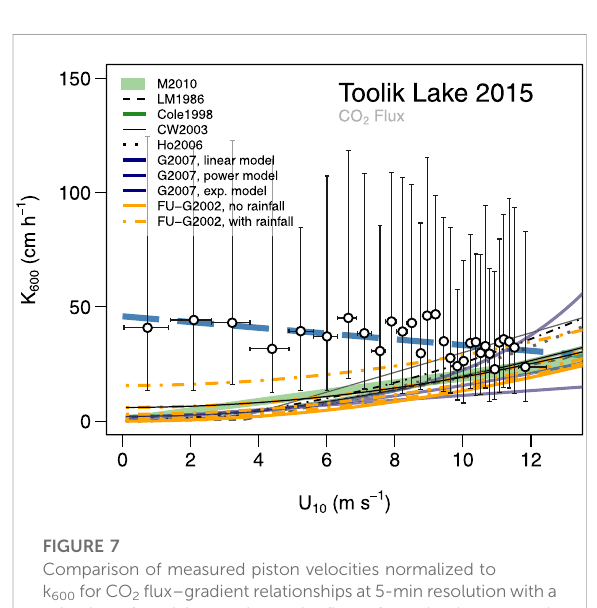
FIGURE 7 Comparison of measured piston velocities normalized to k 600 for CO 2 fl ux – gradient relationships at 5-min resolution with a selection of models to estimate the fl uxes from simpler water – air gradient measurements. Open circles show the median of each bin, approximated by a dashed blue line. Vertical error bars show the inter-quartile range of values (inner 50% of data), whereas the horizontal whiskers show the entire size of the associated bin. Models used are: M2010: MacIntyre et al. (2010), range given by the buoyancy fl ux term; LM 1986: Liss and Merlivat (1986); Cole 1998: Cole and Caraco (1998); CW 2004: Crusius and Wanninkhof (2003); Ho 2006: Ho et al. (2006); G2007: Guérin et al. (2007) with three versions (linear, power, and exponential model); and FU-G2002: Frost and Upstill-Goddard (2002), solid line without precipitation, and dashed lines with 0.05, 0.15, and 0.30 mm h − 1 rainfall. See Table S3 for K 600 model equations used. The U 10 values derived for the 10-m height from local measurements and then enlarged by Charnock ’ s relationship that relates true u p to U 10 (Figure